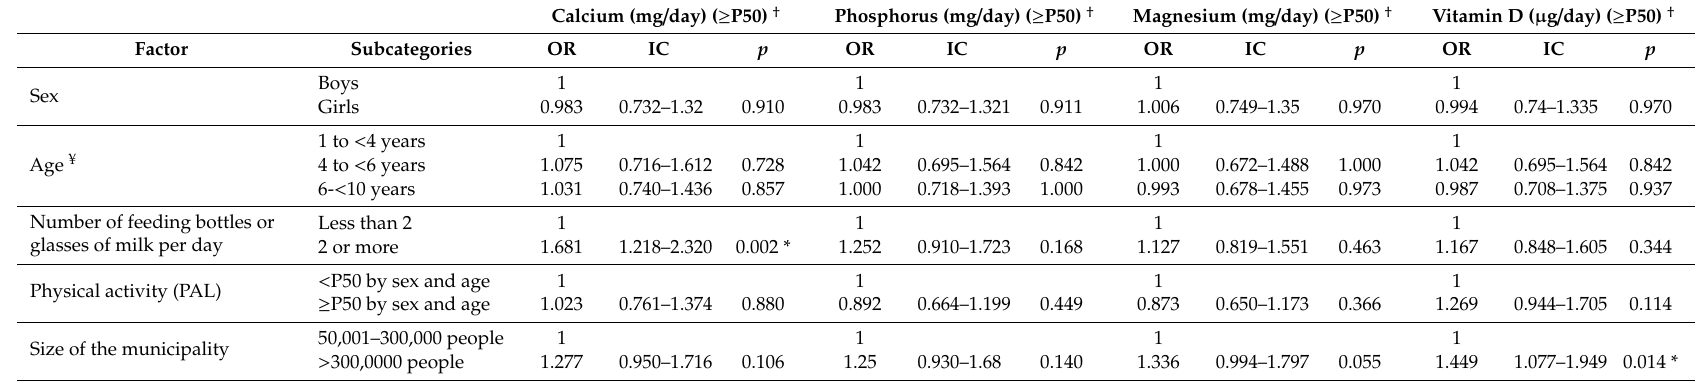
Table 3. Odds ratios and 95% confidence intervals for the presence of an intake similar to or greater than the median of calcium, phosphorus, magnesium, and vitamin D, relative to family and personal factors in the reference sample (RS) of the EsNuPI children population (n =